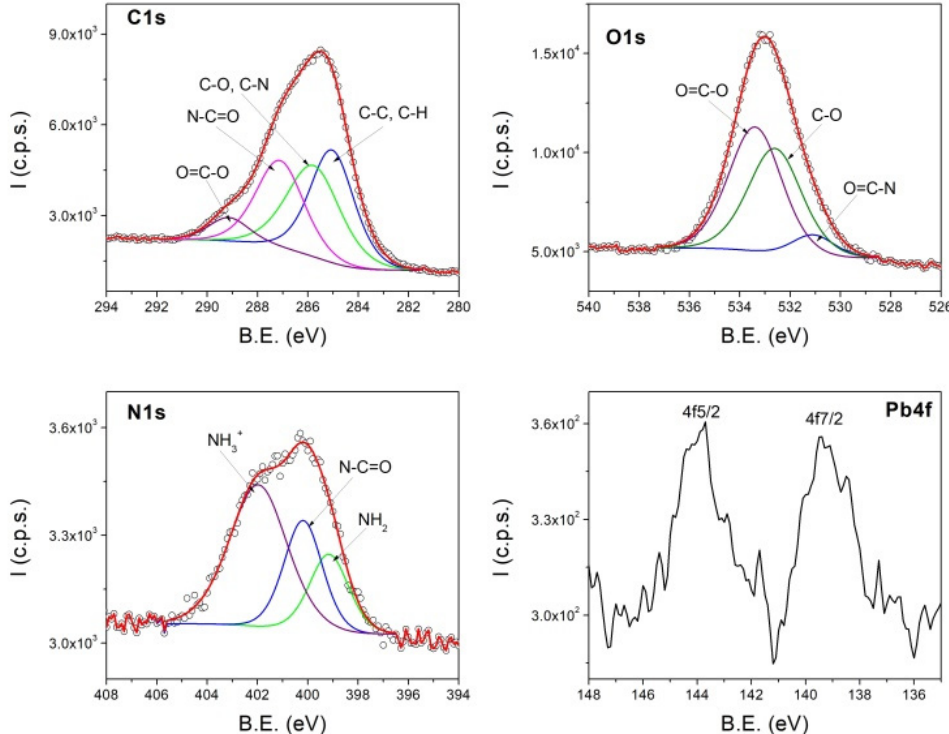
Figure 19. High-resolution XPS spectra of C1s, O1s, N1s and Pb4f core levels from CHIT-PAAA after adsorption of Pb 2+ .